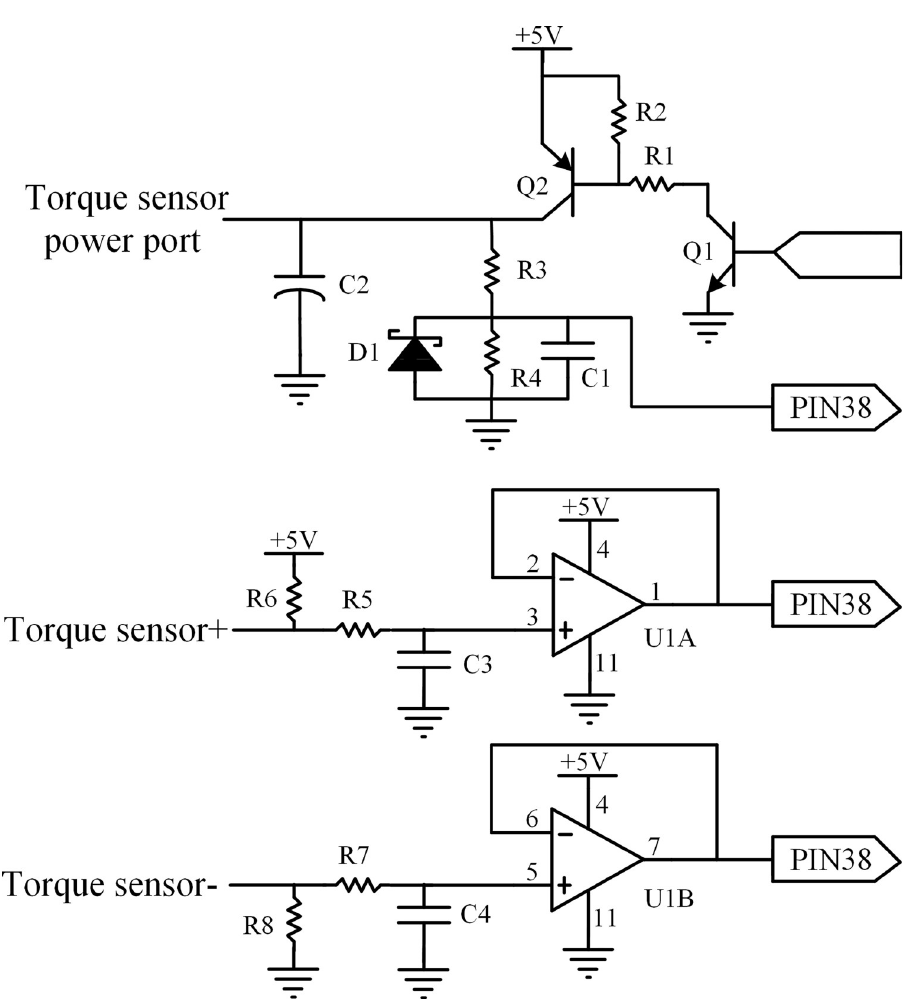
Fig 6. Schematic of the torque detection circuit. respectively. A double loop output circuit is designed in the design of torque detection, which compares the associate torque signal with the main torque signal and estimates the state of the main torque signal to ensure the accuracy of the output signal of the torque sensor. The steer- ing wheel is turned right when voltage signals of main torque more than 2.5V, otherwise the opposite. The value of output voltages is 2.5V if the steering wheel locates in the middle of the steering shaft, which means that the tractor is moving along a straight line. The schematic of the torque detection circuit is illustrated in Fig 6. To reduce the energy consumption of the controller, two transistors are selected to control the +5V DC power for the torque sensor by applying their switch function, NPN and PNP type, respectively. The base of Q1 is controlled by a microcontroller, Q2 and Q1 are opened if the base of Q1 is high level, and then +5V DC is carried to the positive pole of the torque sen- sor. To ensure output voltage and input voltage are similar to the power supply voltage and avoid signal attenuation in the next circuit, a voltage following circuit is designed by using an LM324 operational amplifier.